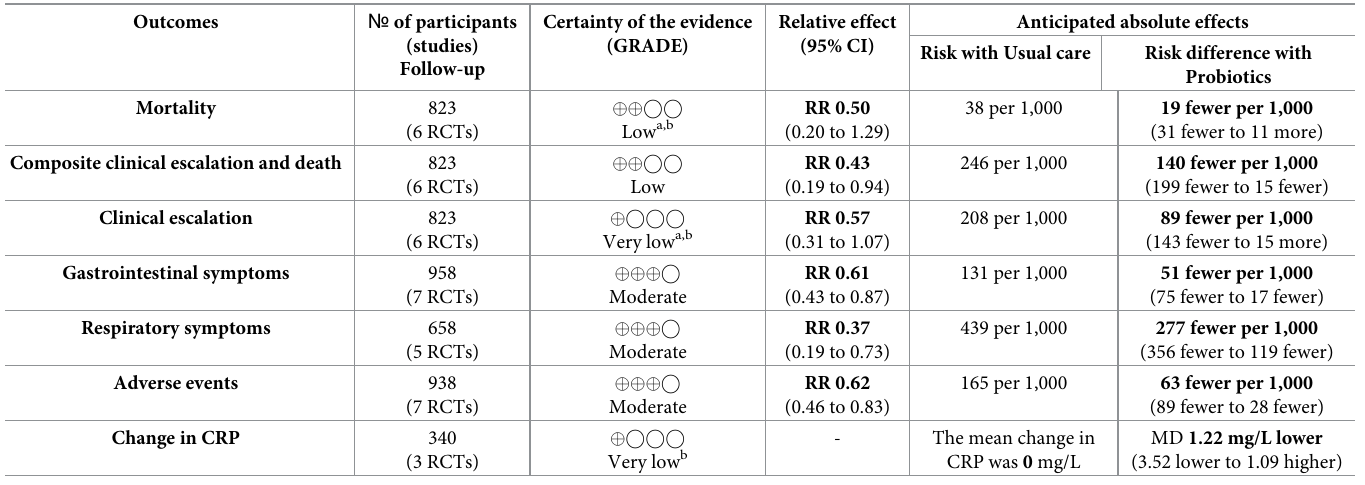
Table 1. Rating the quality of evidence by the GRADE